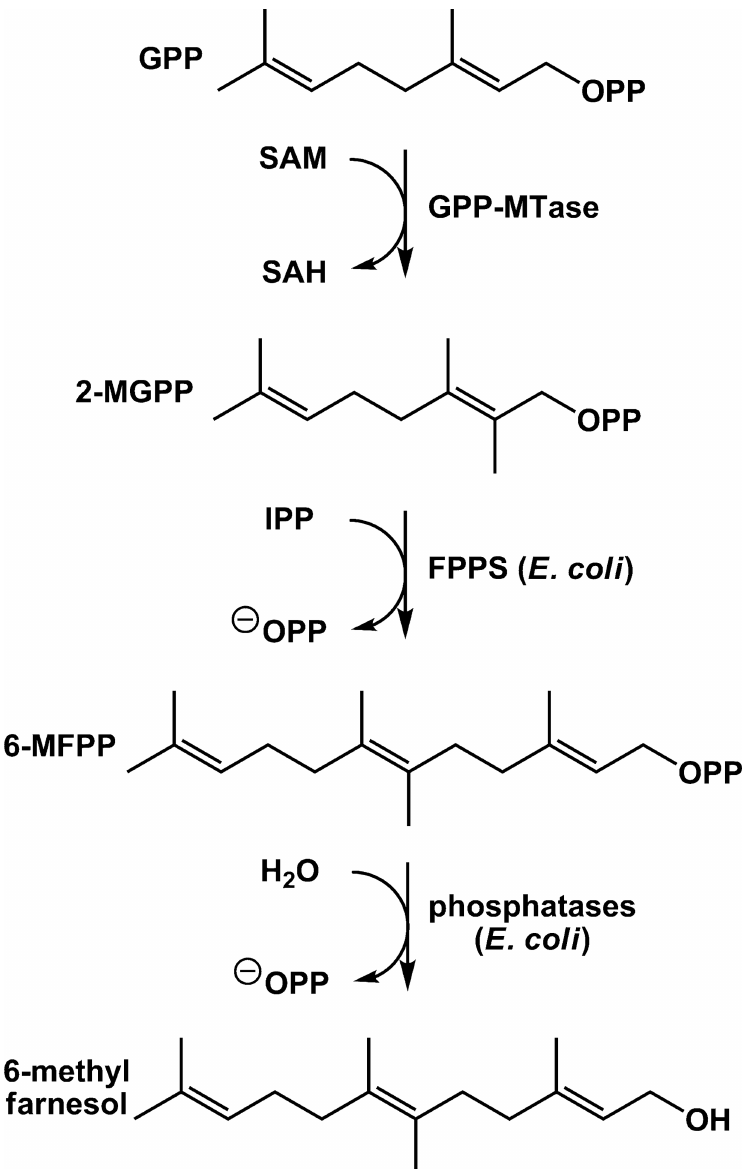
Fig 5. Proposed biosynthesis of 6-methylfarnesol in E . coli expressing the GPP-MTase of S . coelicolor . The elongation of 2-MGPP with IPP by an endogenous FPP synthase (FPPS) to 6-methylfarnesyldiphosphate (6-MFPP) and its dephosphorolation by endogenous phosphatases (probably PgpB and YbjG) are assumed.